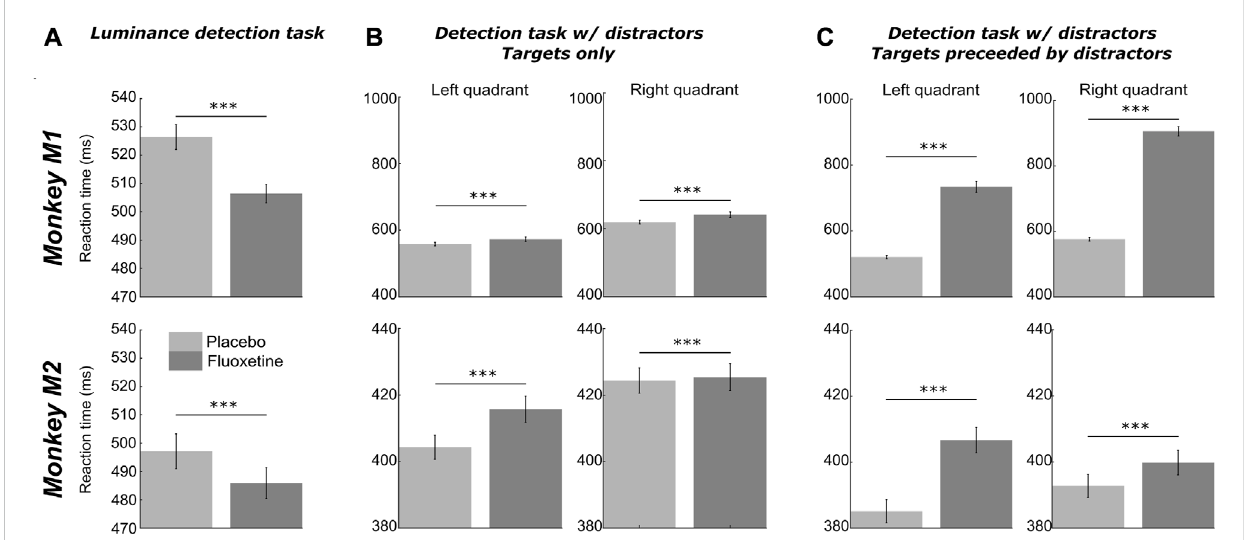
Effect of fl uoxetine on controlled reaction times. Median+/-median absolute error of reaction times, for monkeys M1 (top) and M2 (bottom), in the placebo and fl uoxetine conditions in the luminance task (A) , all positions collapsed, high luminance targets only), in the detection tasks with distractors, on target only trials (B) , and in trials with distractors (C) . Statistical signi fi cance is represented as follows: ***, p < 0.001; **, p < 0.01; *, p < 0.05. See also companion Supplementary Table S7 for detailed